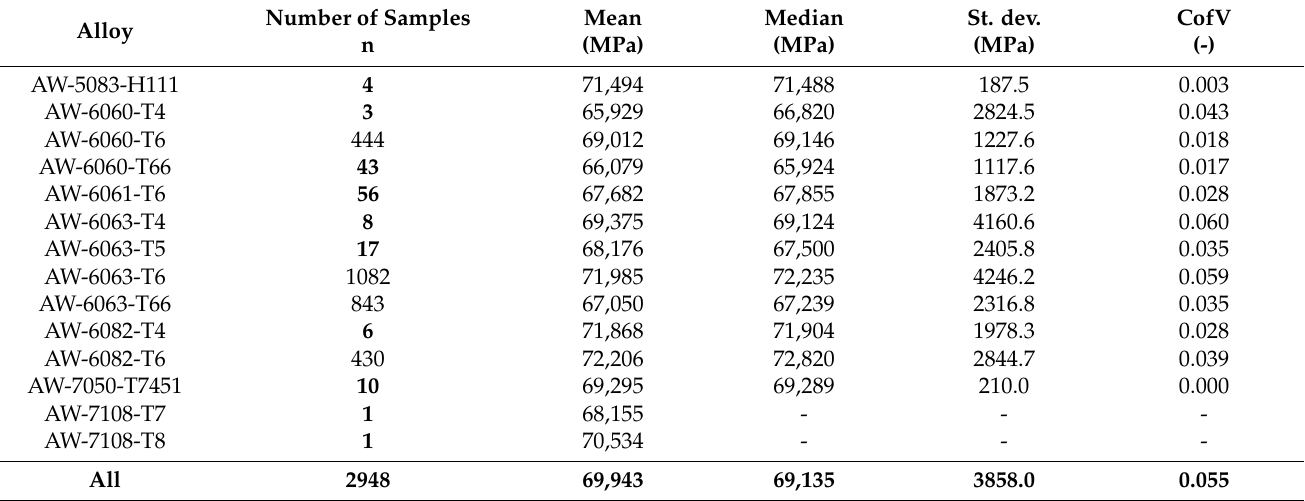
Table 6. Statistical analysis of Young’s